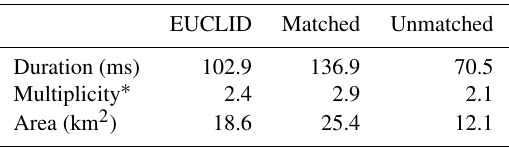
Table 4. Average characteristics of all EUCLID flashes, those ob- served by the ISS-LIS (matched), and those not observed by the ISS-LIS